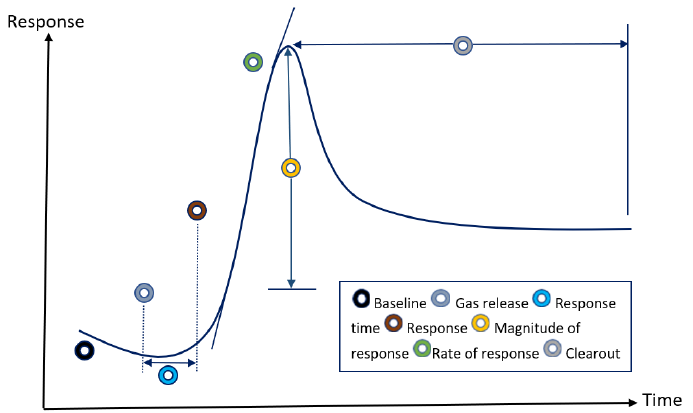
Figure 5. Scenario of estimated leak reaction recording while using the tracer gas approach